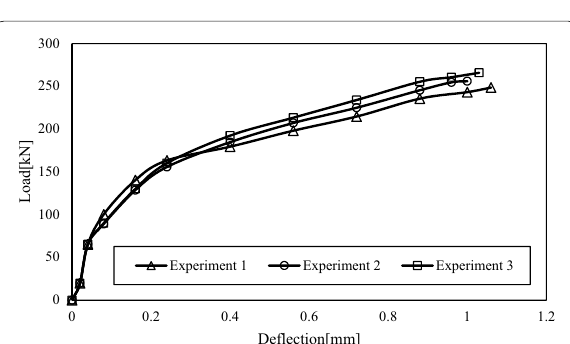
Fig. 18 Load–deflection diagram of the sleeper-included negative bending moment of the